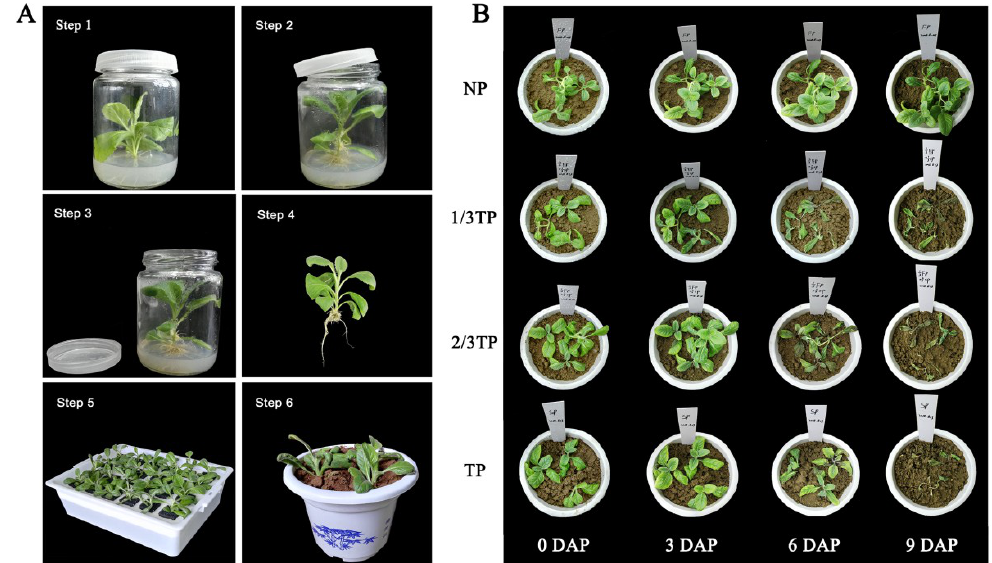
Figure 7. The operation process for acclimatization and the phenotype changes of R. glutinosa in the experiment. Obvious irreversible injury occurred at 6 DAP until death at 9 DAP. ( A ) The six main